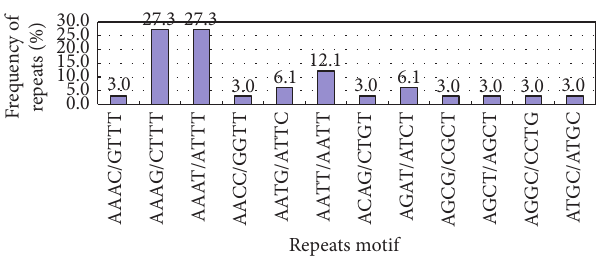
Figure 5: Tetranucleotide repeats of Unigene.